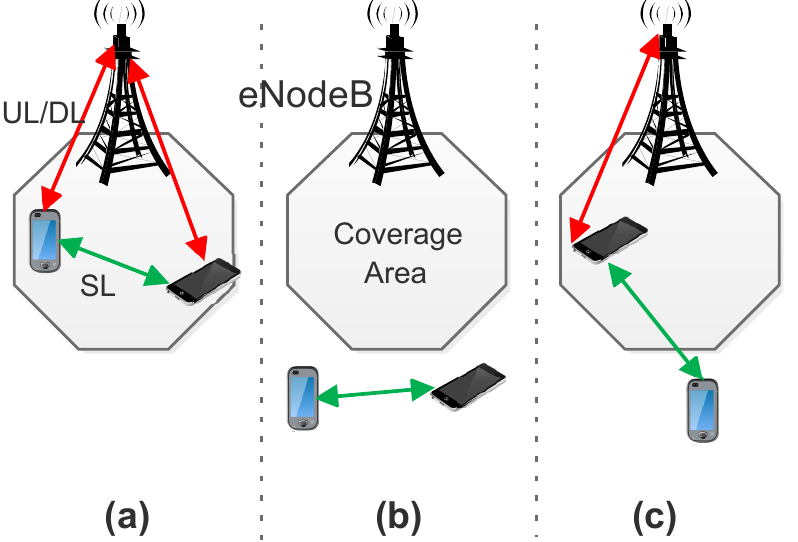
Figure 2. D2D communication scenarios: ( a ) within network coverage, ( b ) outside network coverage, and ( c ) partial network